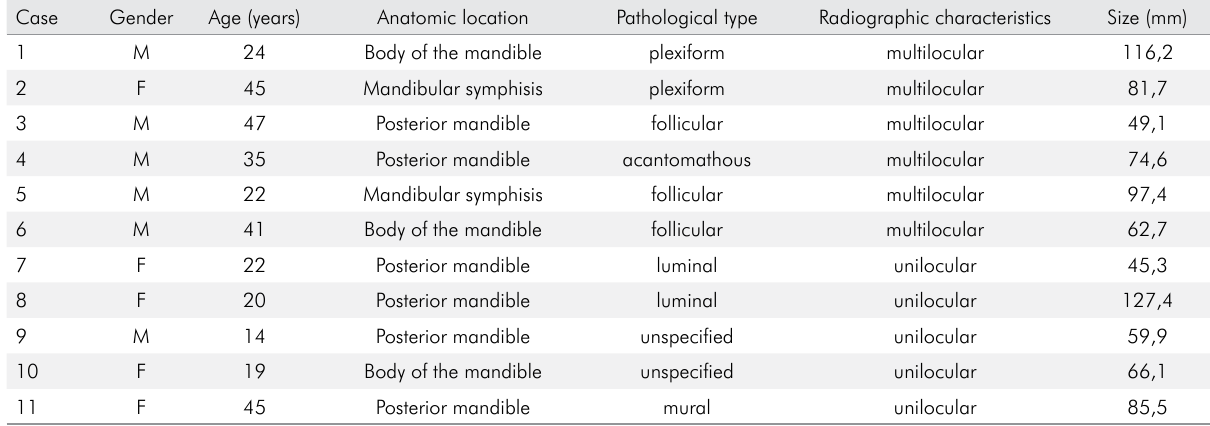
Table 1. Clinical and pathological features of the ameloblastoma